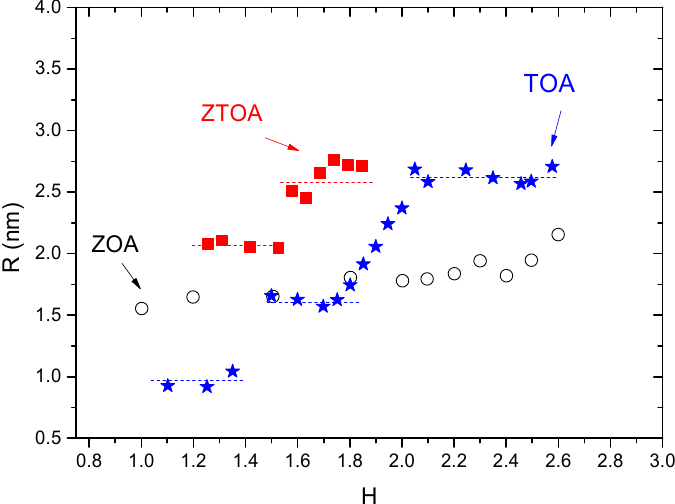
Figure 6. Initial sizes of particle (R) during the induction period of sol–gel process for different hydrolysis ratios with blue star for TOA, circle for ZOA and red square for ZTOA (Reprinted/adapted with permission from Refs. [80,81,94], Copyright © 2023, American Chemical Society, © 2023 Elsevier B.V. and © 2023 Royal Society of Chemistry).